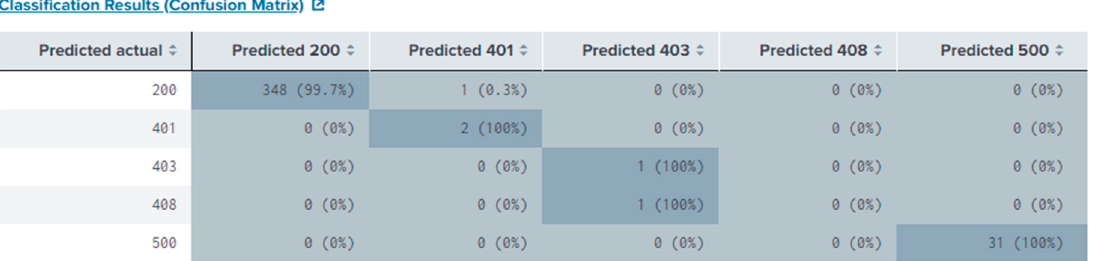
Figure 3. Confusion matrix of HTTP Status code prediction.